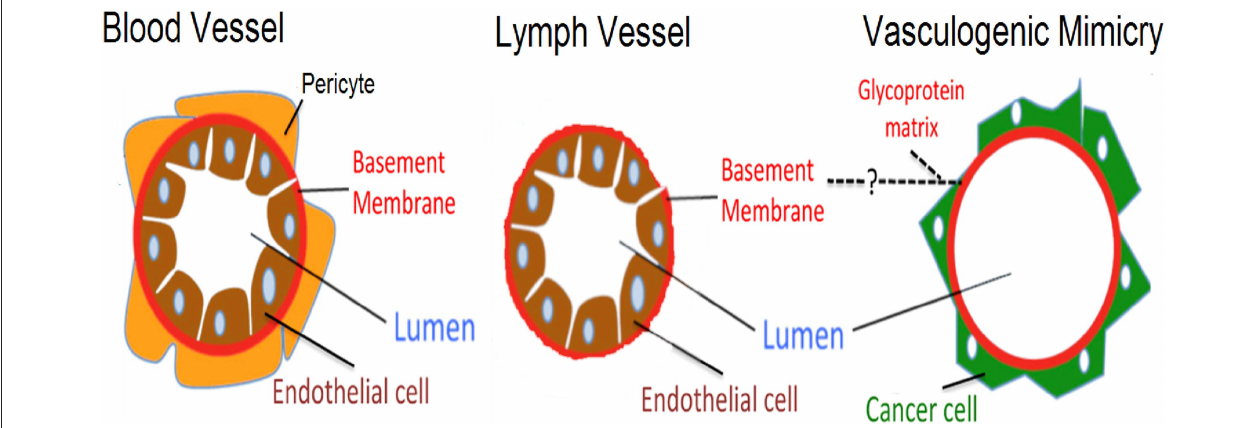
FIGURE 1 | Schematic representation highlighting differences between blood vessels, lymph vessels, and VM structures. Differences are shown between an endothelial lined blood vessel ( left side ), a lymph vessel ( center ), and the hypothesized VM structure ( right side ). Blood vessels present an external layer of pericytes which overlay a basement membrane, with endothelial cells lining the luminal side. In lymph vessels, a similar architecture is present, however pericytes are absent and the basement membrane is thinner. Finally, the proposed structure present in VM has cancer cells sitting on the non-luminal side of a glycoprotein-rich (PAS + ) matrix, with the total absence of endothelial